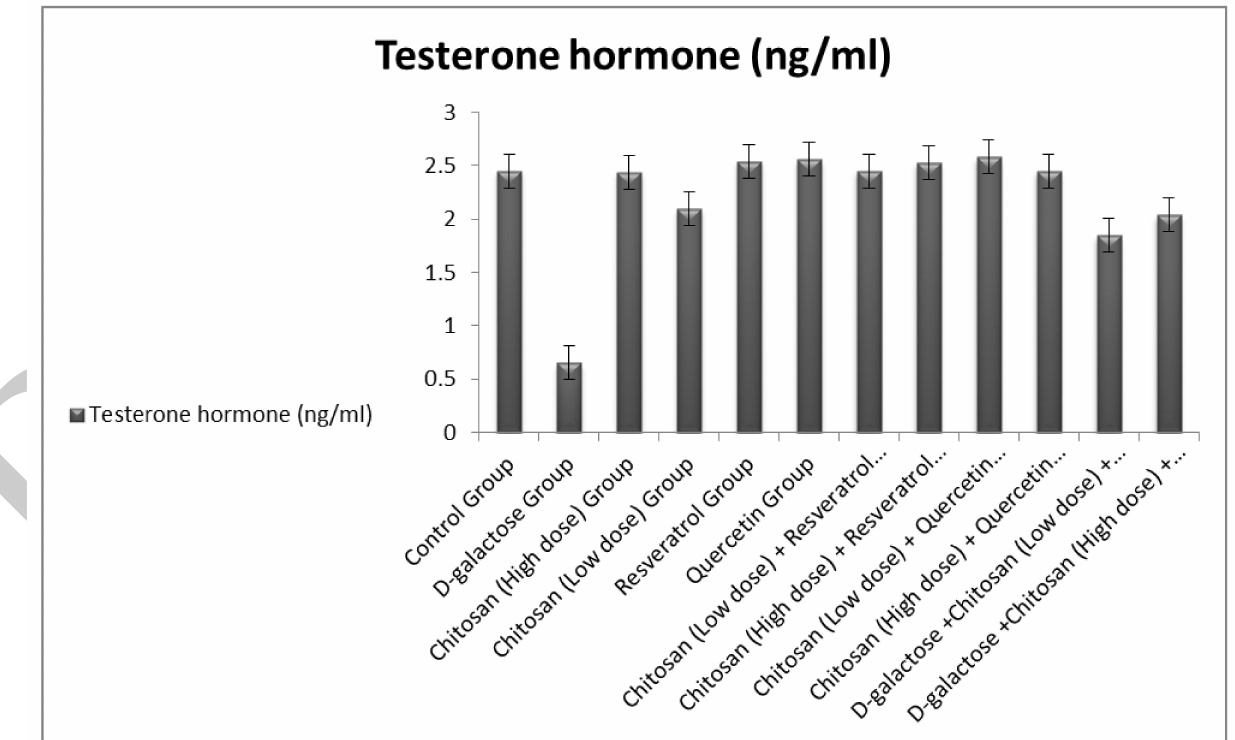
Figure 3. Effect of D-galactose, Chitosan nanoparticles, correcting and Resveratrol on testosterone hormone level (ng/mL) in male